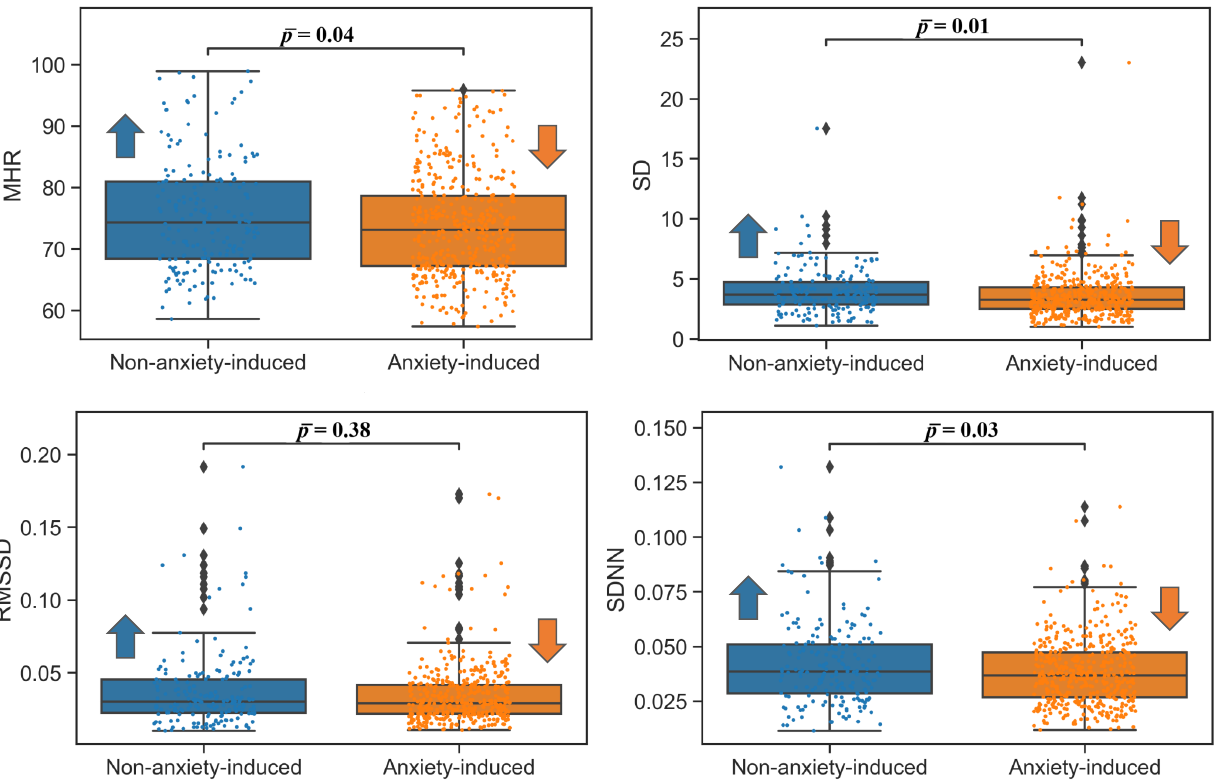
Figure 1. Box plots of the time domain ECG features in the nontransitional video phases. Mean heart rate: MHR ( bpm); standard deviation of the heart rate: STDHR; root mean square of successive differences: RMSSD; standard deviation of NN intervals: SDNN. Arrows indicate which of the two populations (non-anxiety-induced state or anxiety-induced state) had a higher (upward arrow) or lower (downward) value for ease of